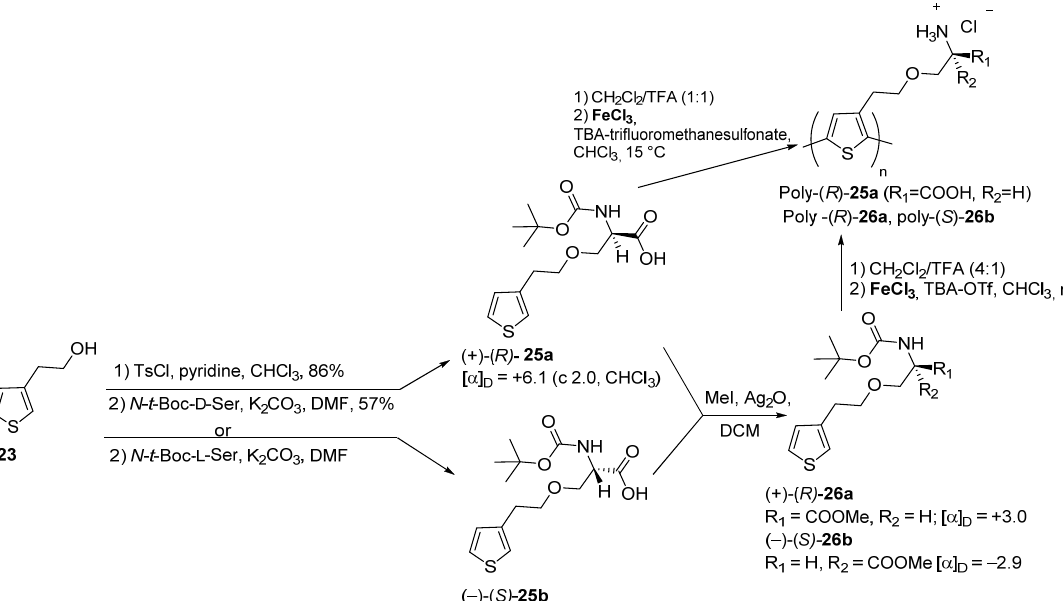
Scheme 6. Synthesis of 3-[2-(( S )-(1)-2-methylbutoxy)ethyl]thiophene 24 and its polymerizations.